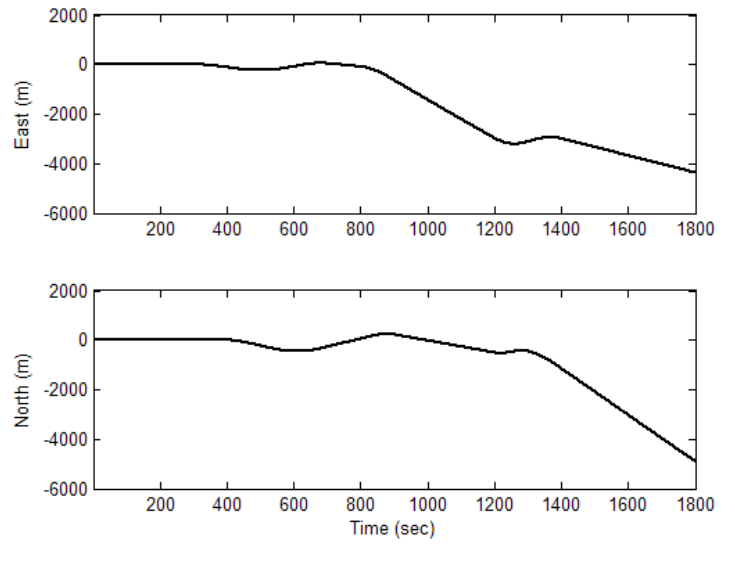
Figure 8. East and north components of INS navigation